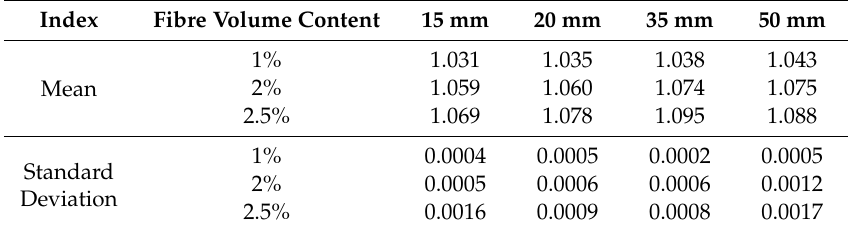
Table 5. Mean and standard deviation (STD) of relative magnetic permeabilities of all plates.